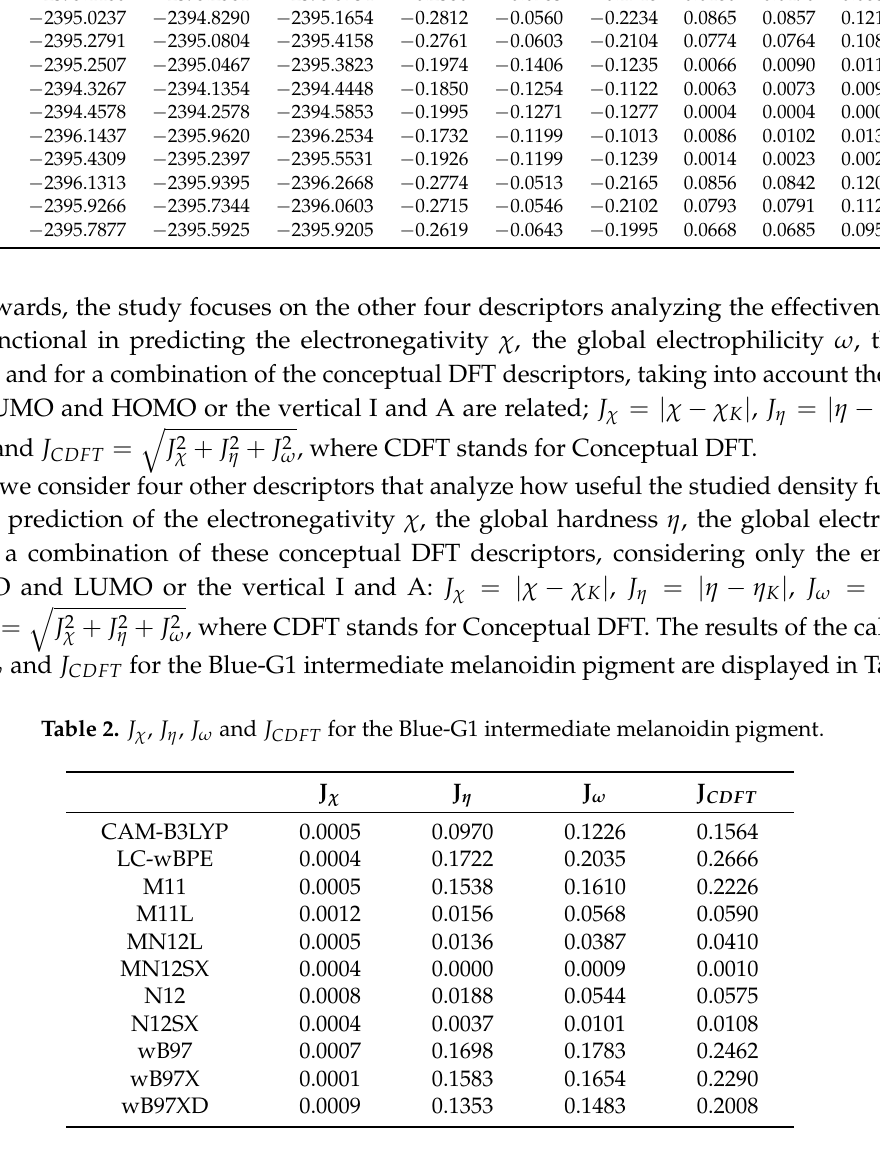
Table 1. Electronic energies of the neutral, positive and negative molecular systems (in au) of Blue-G1, the HOMO, LUMO and SOMO orbital energies (also in au), J I , J A , J HL and ∆ SLdescriptors calculated with the eleven density functionals and the Def2TZVPbasis set using water as as solvent simulated with the Solvation Model Density (SMD) parametrization of the Integral Equation Formalism-Polarized Continuum Model (IEF-PCM) model. Eo E+ E- HOMO LUMO SOMO J(I)